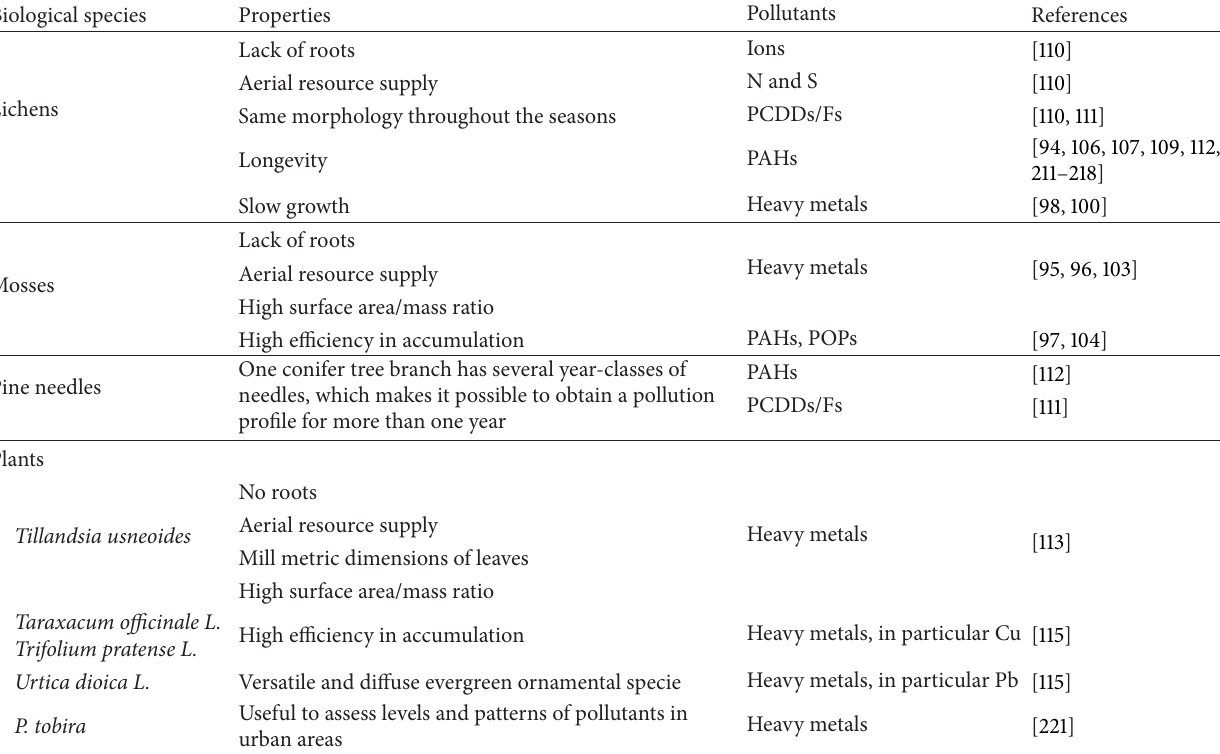
Table 13: Most common biological species used in biomonitoring with main properties and